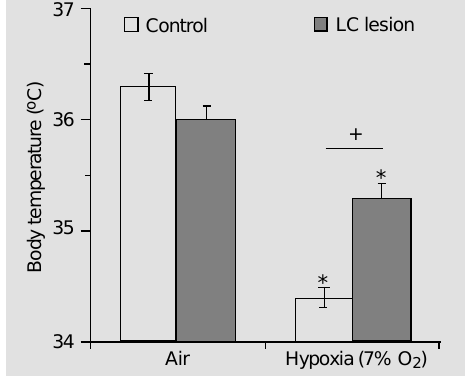
Figure 3 - Effects of hypoxia on body temperature of the control group (N = 16) and locus coeru- leus (LC)-lesioned rats (N = 7). Values are reported as means ± SEM. *Significant reduction (P<0.05) of mean body tempera- ture after hypoxia. + Significant reduction (P<0.05) in the magni- tude of hypoxia-induced